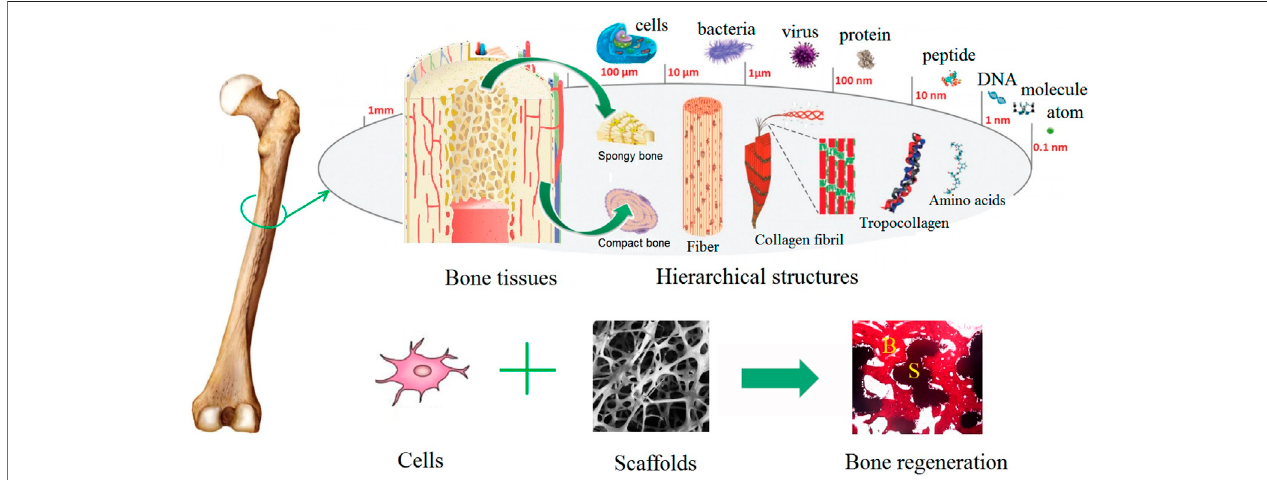
FIGURE 1 | Illustration of the hierarchical structure of bone. Reproduced from Chen X. et al. (2018) under Creative Commons Attribution (CC BY) license (CC BY 4.0) (https://creativecommons.org/licenses/by/4.0/).